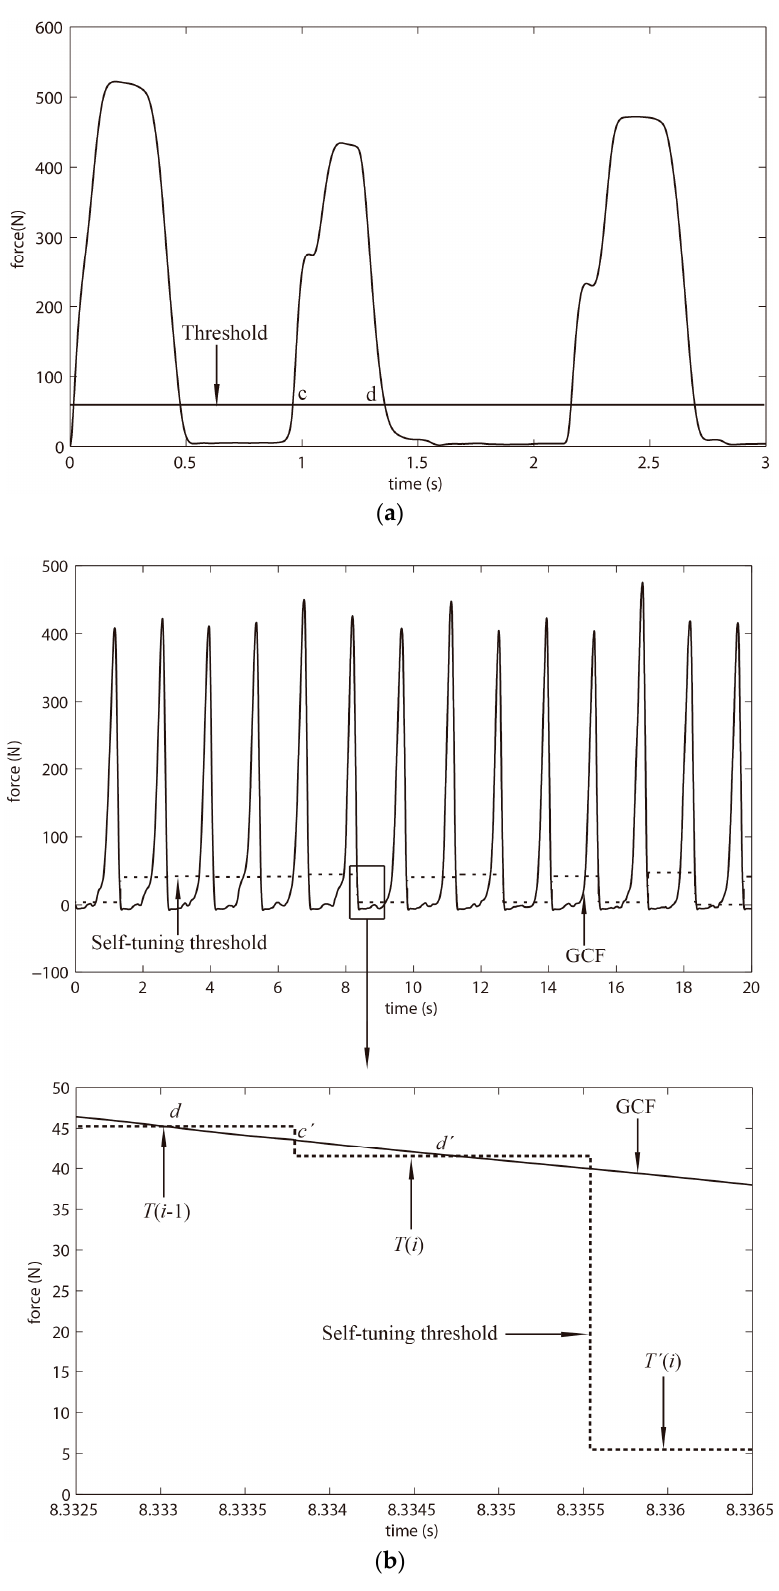
Figure 6. ( a ) the description of using one threshold for threshold adjustment; ( b ) demonstration of threshold adjustment using one threshold and analysis of twice threshold computations.